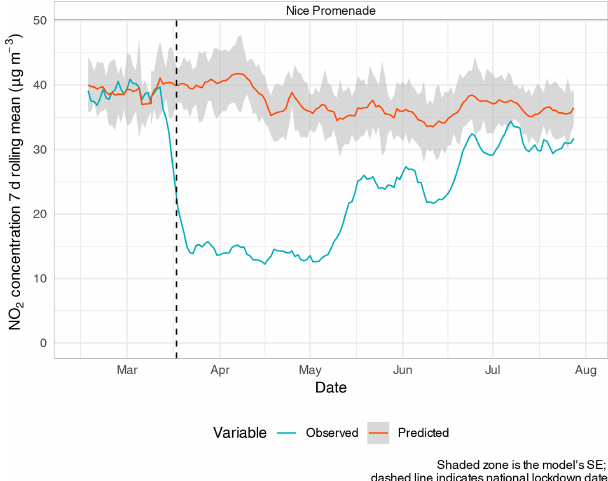
Figure 3. An NO 2 example where the observed concentrations clearly diverged from the business-as-usual (BAU) scenario for the Nice Promenade (France) traffic monitoring site between February and July